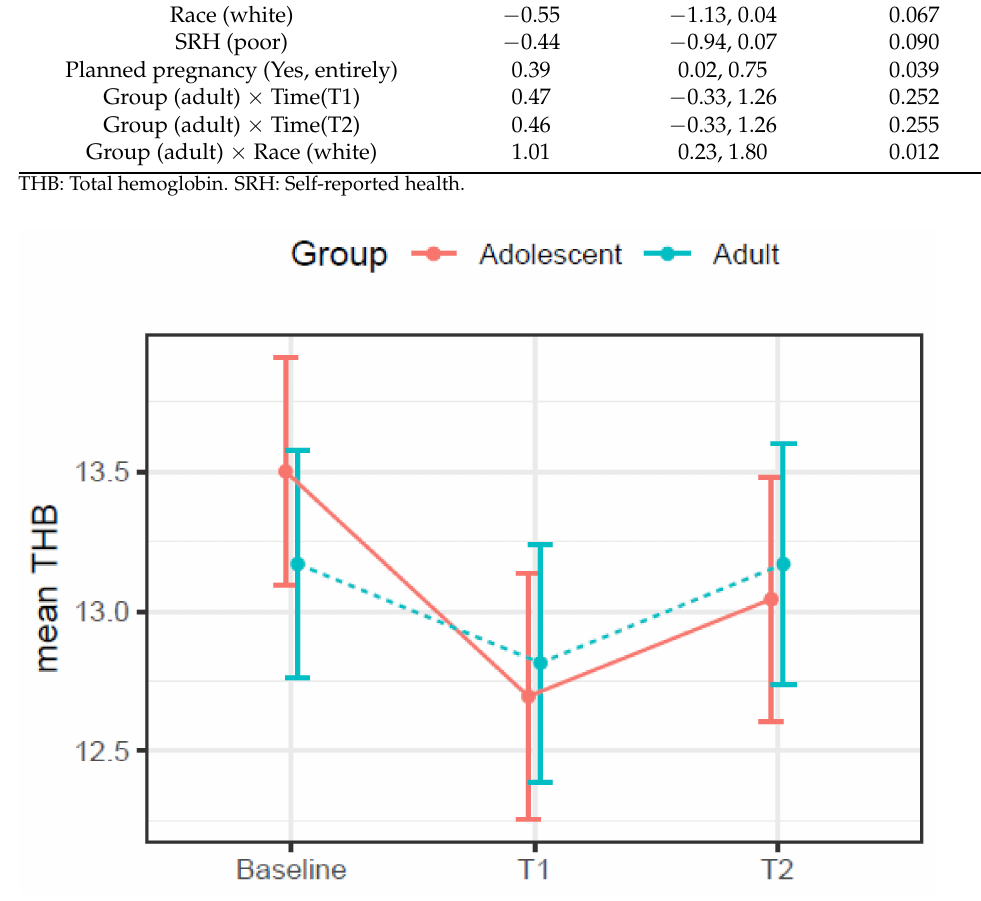
Figure 2. THB variation from the first 16 weeks of pregnancy (baseline) to the third trimester (T1) and the 4 to 6 weeks postpartum (T2) for adolescents and adults. Trairi Region, Rio Grande do Norte, Brazil,